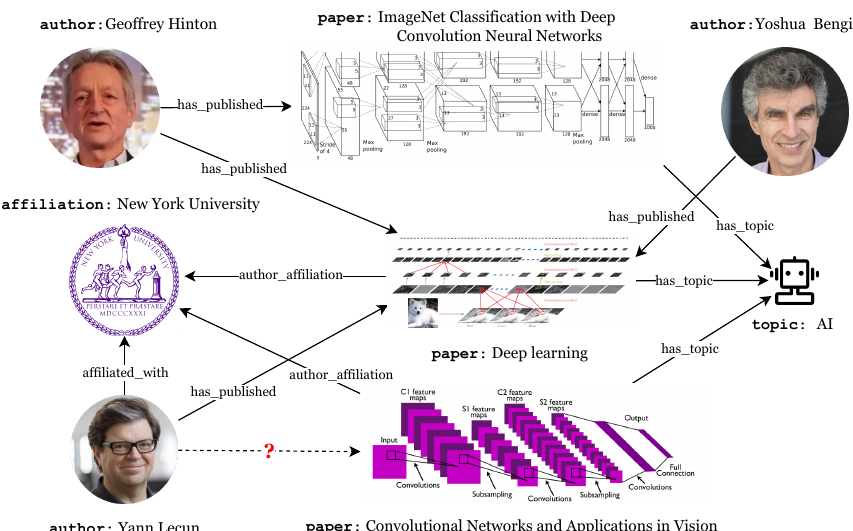
Figure 1. Academic knowledge graph completion. This paper focuses on addressing this task through link prediction—for example, inferring the relation between “author: Yann Lecun” and “paper: Convolutional Networks and Applications in